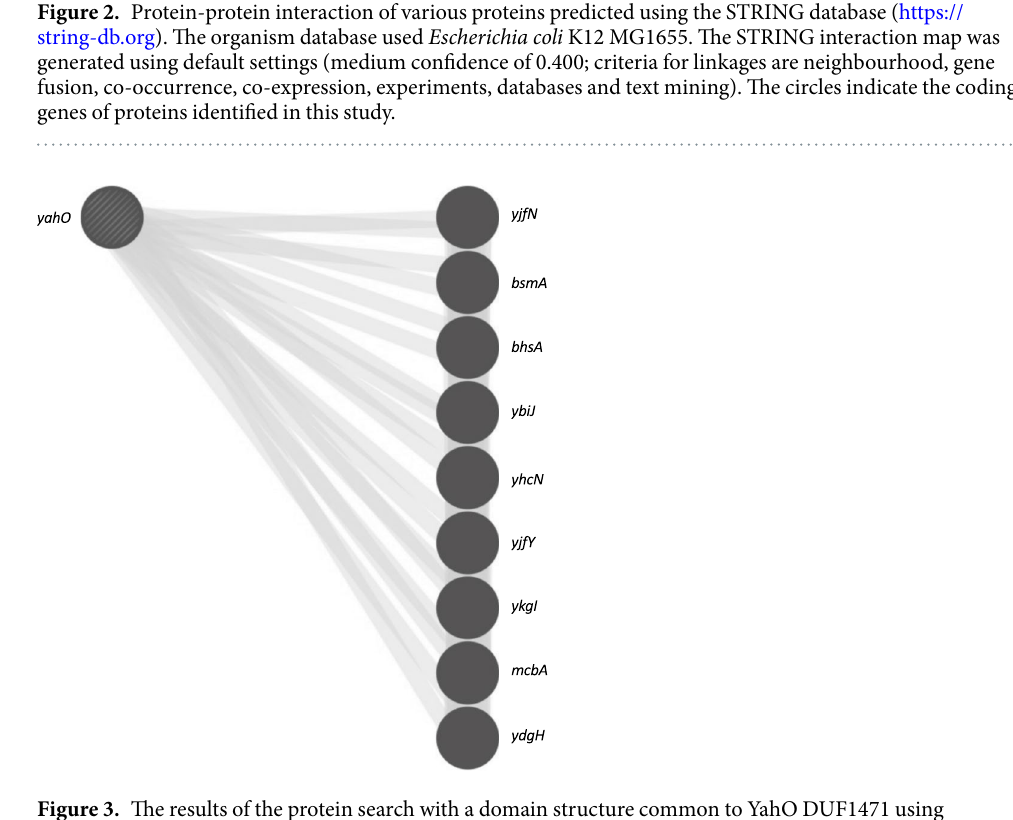
Figure 3. The results of the protein search with a domain structure common to YahO DUF1471 using GeneMANIA (https://genemania.org). The bsmA and bhsA are the coding genes of biofilm related proteins, and mcbA is the coding gene of colonic acid mucoidy stimulation protein. The yjfN , ybiJ , yhcN , yjfY , ykgI and ydgH are the coding genes of hypothetical